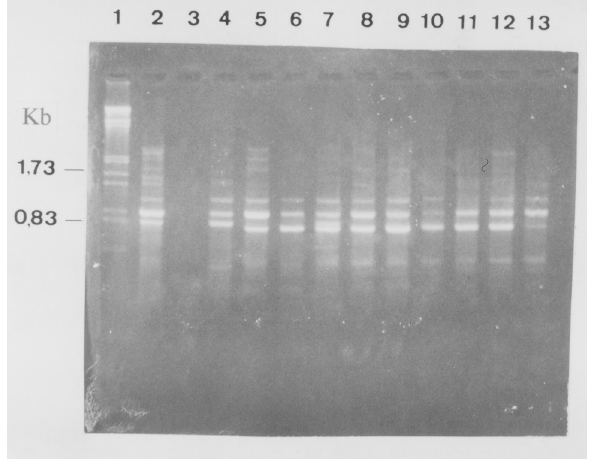
Figure 2 - Random amplified polymorphic DNA from 12 isolates of Drechslera tritici-repentis using primer B06. Lanes are as follows: (1) λ; Hind III- Eco RI; (2) CEP24-Selbach; (3) E24-Butiá Gr./Sertão; (4) E16- Selbach; (5) E16-Não-Me-ToqueII; (6) E16-Coxilha; (7) C19-Cruz Alta; (8) PF90120- Passo Fundo; (9) E16-Vacaria; (10) E16-Ronda Alta; (11) BR23-Santa Rosa; (12) E15-Lagoa Vermelha; (13) E16-Não-Me-ToqueI. The numbers on the left are the lengths of the marker bands in kilobases.